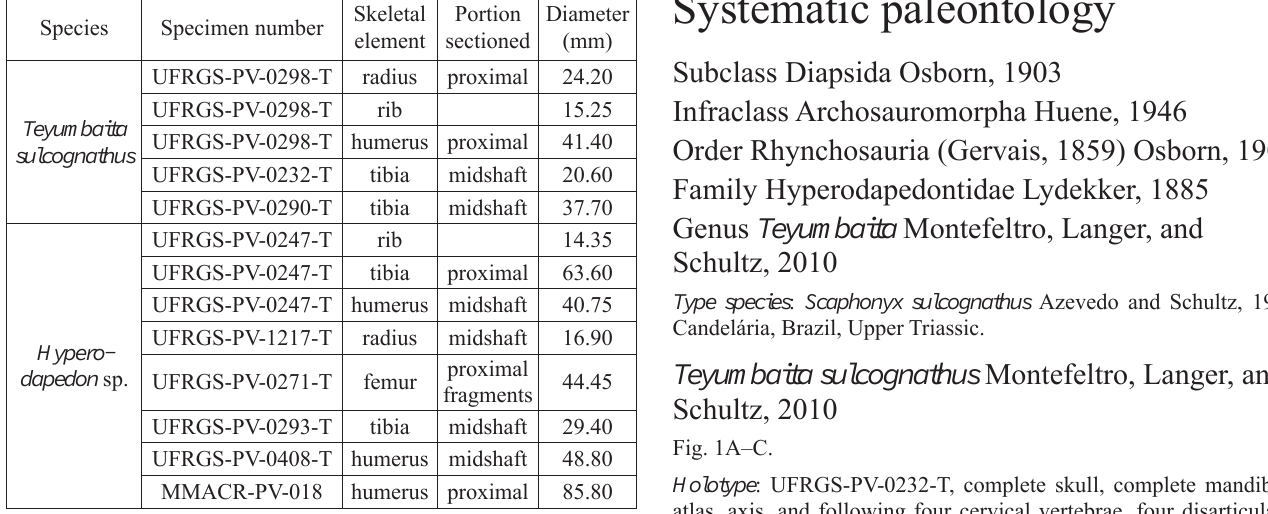
Table 1. Specimens thin sectioned in this study.